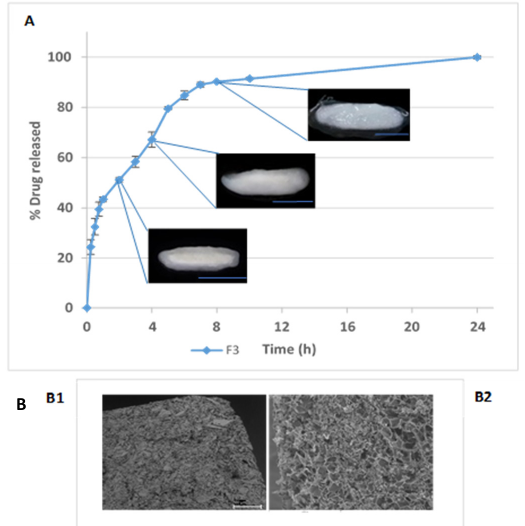
Figure 5. ( A ) F3 release profile and photograph of the tablets after 1, 4 and 8 h in FaSSIF (scale bar: 1 cm). ( B ) SEM images on tablet surface (( B1 ): dry tablets; ( B2 ): tablets moistened following 8 h incubation with phosphate buffer and freeze-dried subsequently).